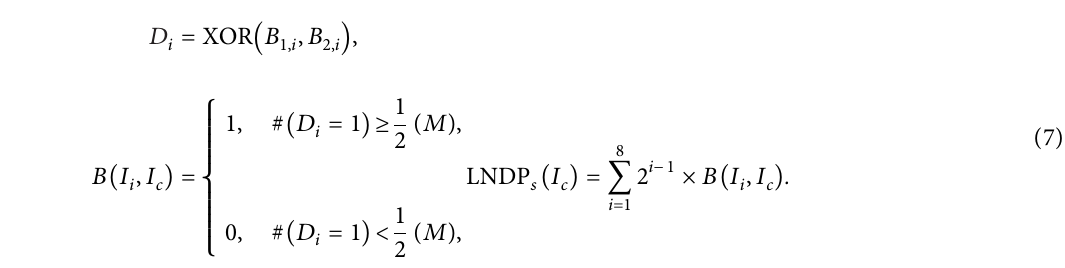
Figure 4: Local neighborhood enhancement mode